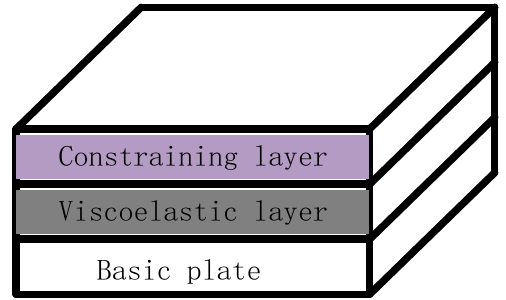
Figure 1. The structure of PCLD treatment.